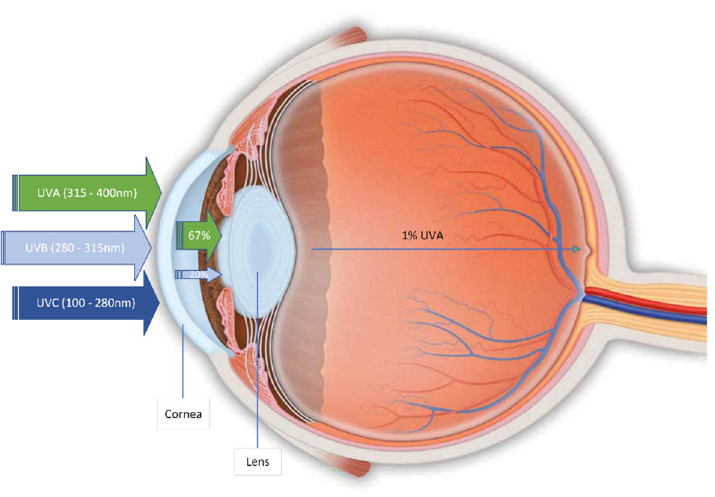
Figure 2. Solar UVR absorption by the eye elements.